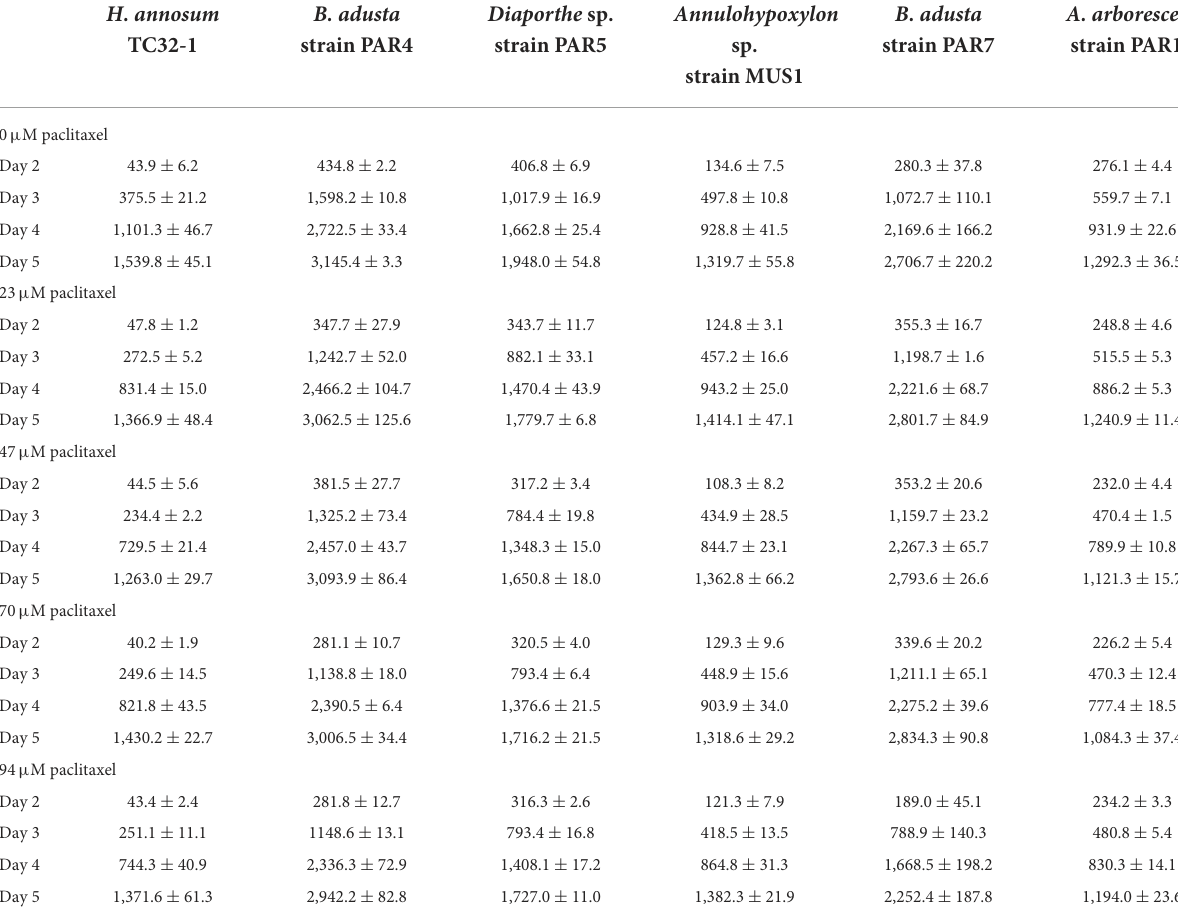
TABLE 3 Comparison of growth area for the fungi grown in MMN media at increasing concentrations of paclitaxel. H.